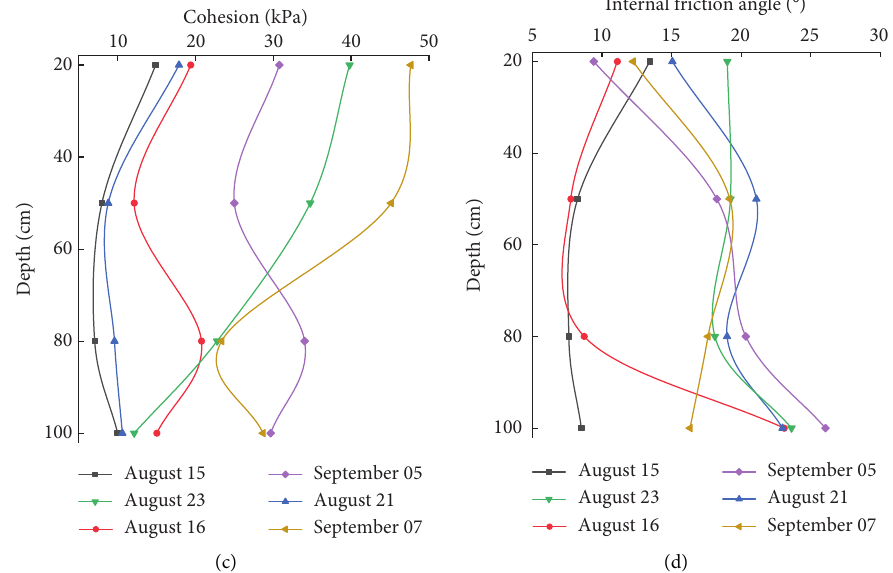
Figure 9: The relationship between various factors and the depth of the slope. (a) Moisture content. (b) Density. (c) Cohesion. (d) Internal friction angle.